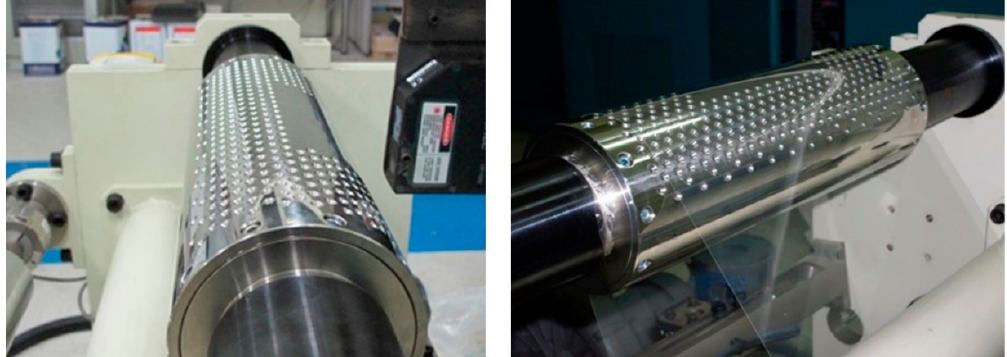
Figure 7. Experimental setup for the air bar, with a laser-based sensor used for flotation detection.